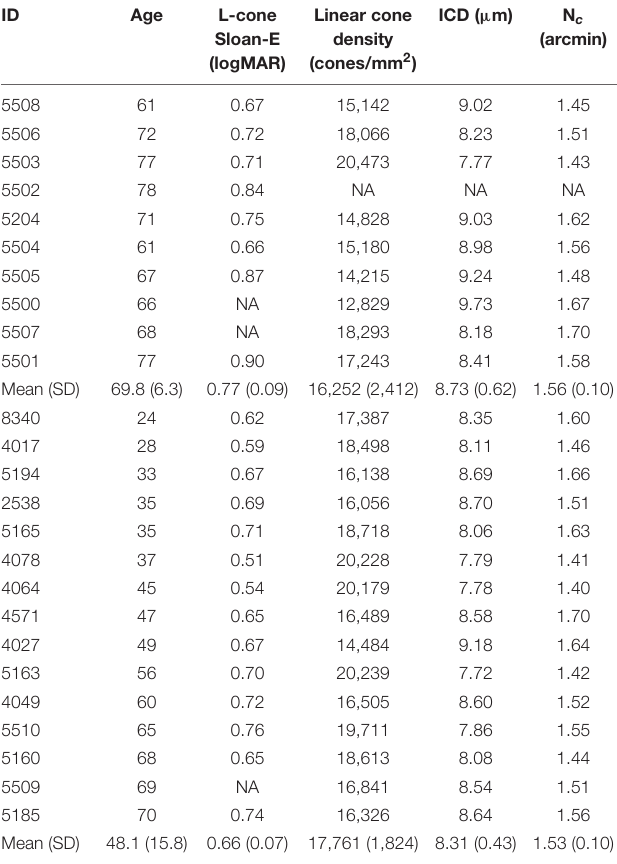
TABLE 3 | Results from perifoveal L-cone isolated Sloan-E letter acuity measured, cone photoreceptor imaging, inter-cone distance (ICD), and Nyquist sampling limit (N c ) at 5 degree